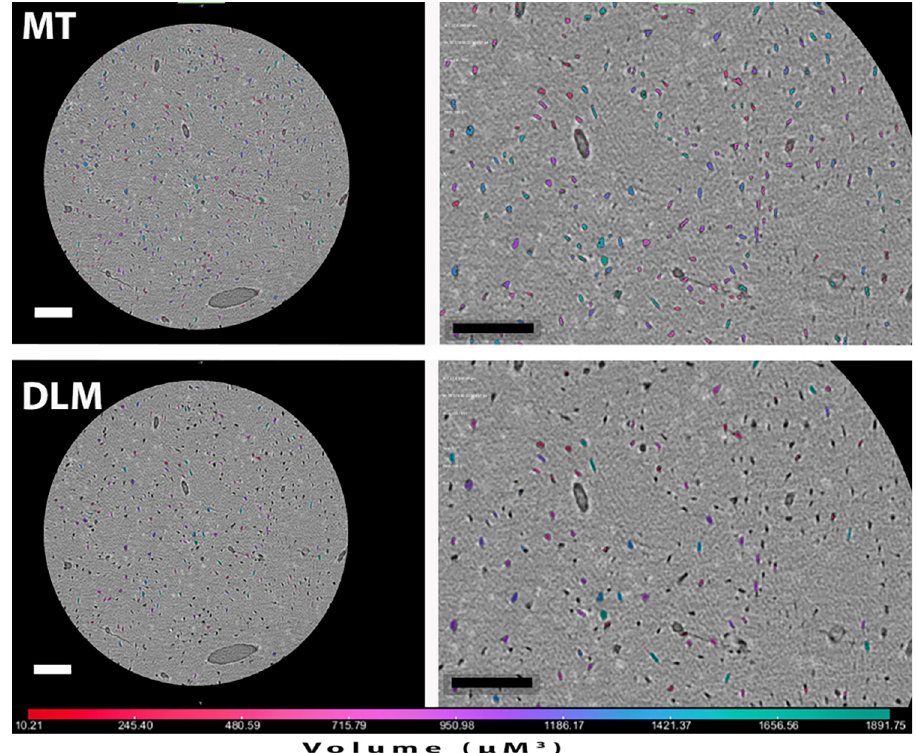
Fig 3. High resolution μ -CT tomogram slice of the inner layer sample (IP2) after MT (top) and DLM (bottom) segmentation. Left images show the whole field of view at the same slice location, and right images show insets of the OL labels as obtained from the two different segmentation approaches. Colors are a qualitative indication of the volume of the OL labels. Scale bars = 100 μ m.